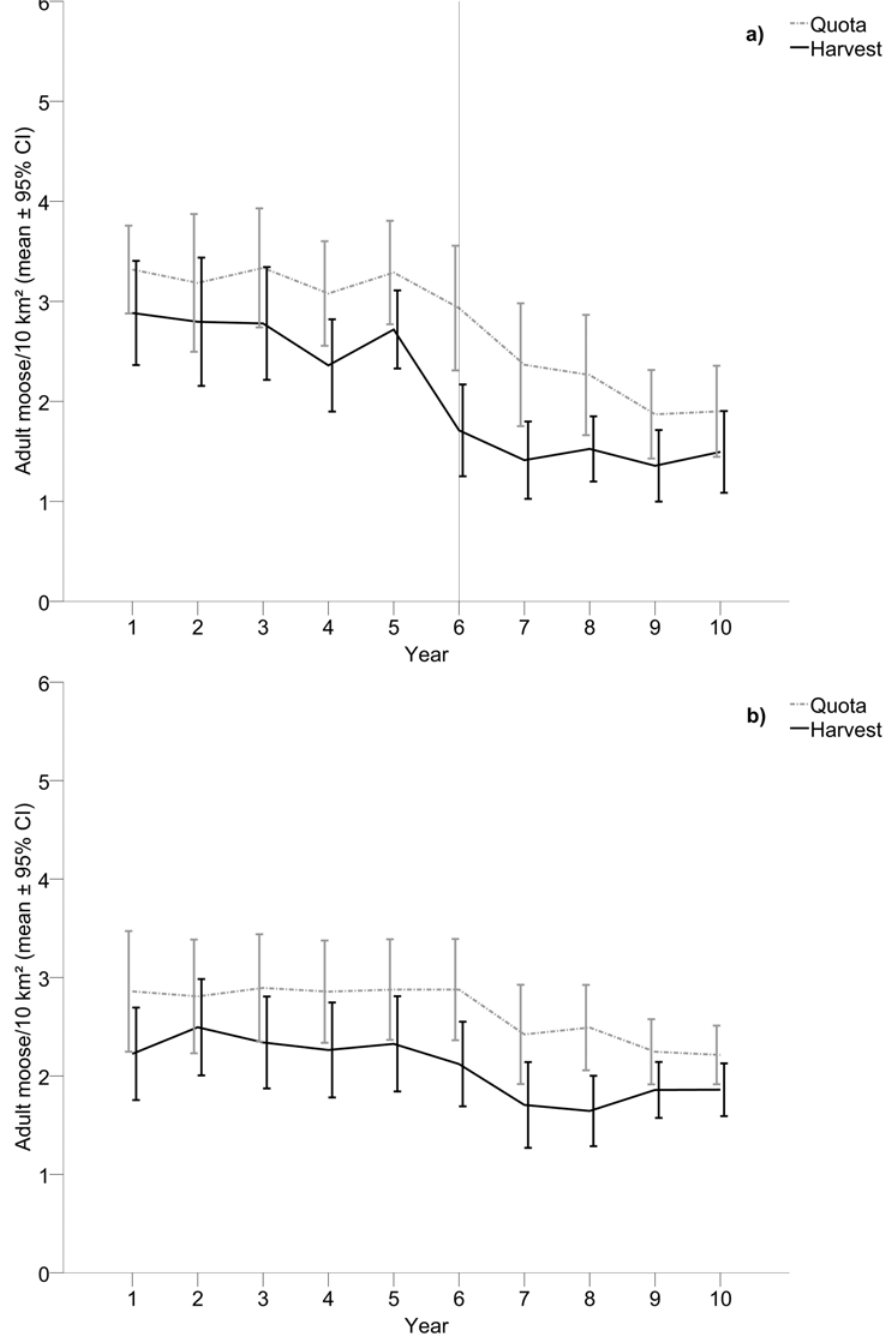
Fig 3. Quota and harvest of adult moose within wolf territories compared to control areas. Quota and hunter harvest of adult moose (males and females pooled) within a) wolf territories (n = 22) and b) control areas during five years prior to wolf establishment and five years with wolf presence. The vertical line in a) indicates the first year with wolf presence.